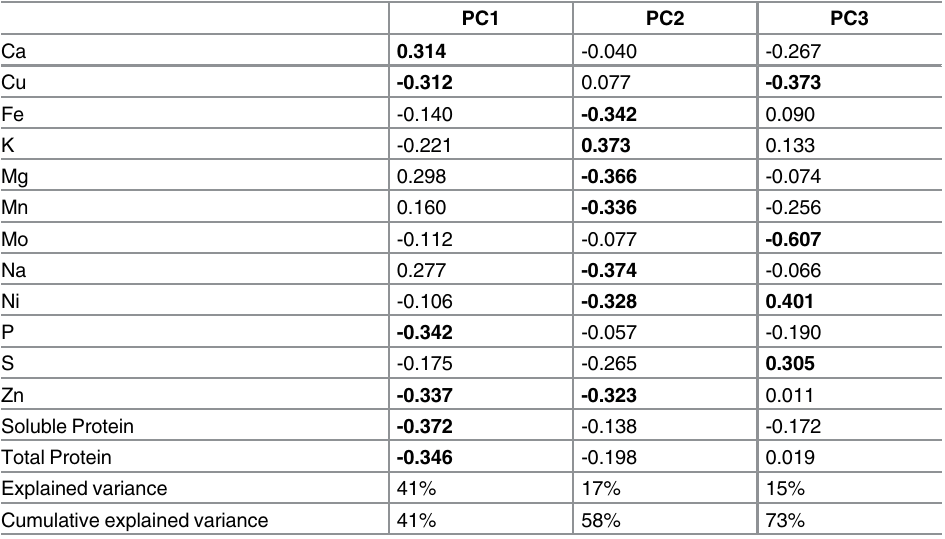
to examine this variation across the family, our study shows that no species is high in all or even most nutrients. It highlights wide variation across the genus, with each species (except M . hildebrandtii ) having the highest median value for at least one nutrient (Table 1), with consid- erable statistical overlap between the ranges across species (Figs 1 and 2). In addition, it points to some potential causes of this variation as well as directions for improvement of cultivated Moringa for different applications. We treat these issues briefly here, starting with protein. Table 4. First three principal components from the PCA and variance explained by each, with nutri- ents with high loadings in each component shown in